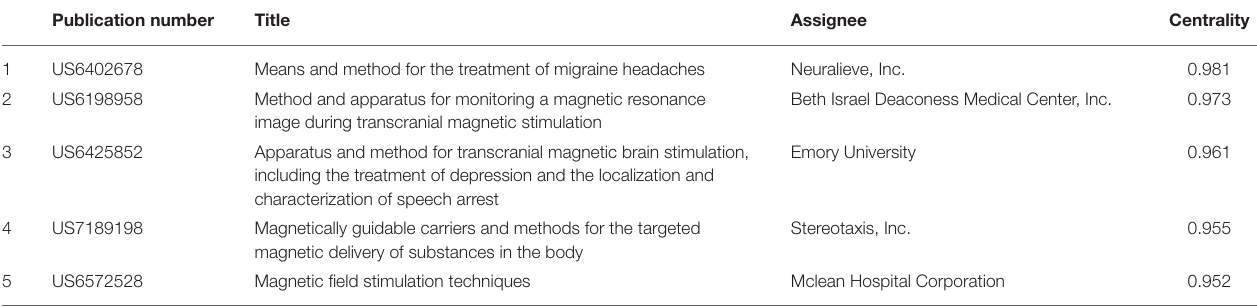
TABLE 9 | Top five central patents for the magnetic energy-based therapeutic technological domain with their assignees and centrality values.